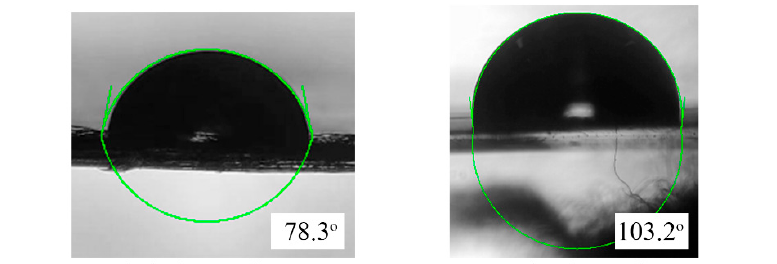
Figure 5. Contact angle measurement on the PE film before and after Rain-X surface treatment.